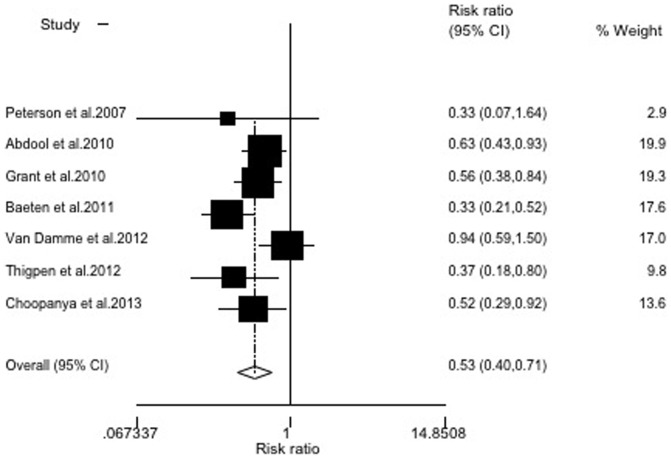
Random-effects model meta-analysis.Heterogeneity chi-squared = 11.91 (d.f. = 6), P = 0.064; test of RR = 1∶z = 4.29, P<0.001.